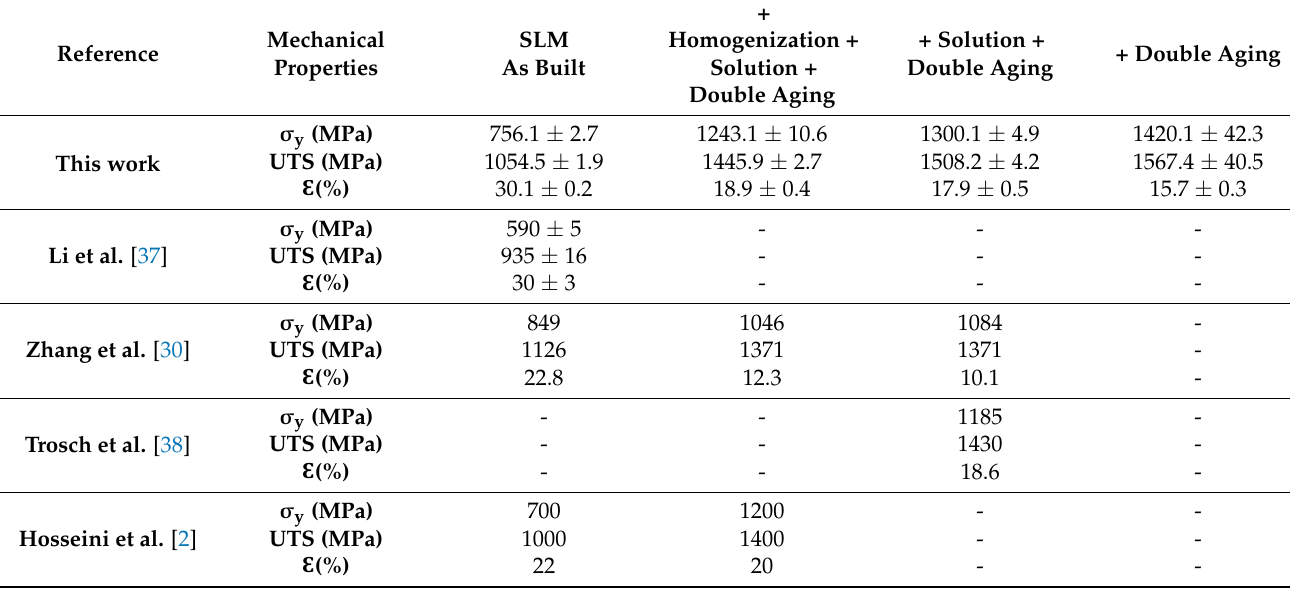
Table 5. Summary of mechanical properties for SLM IN718 alloy in this work compared to other authors.